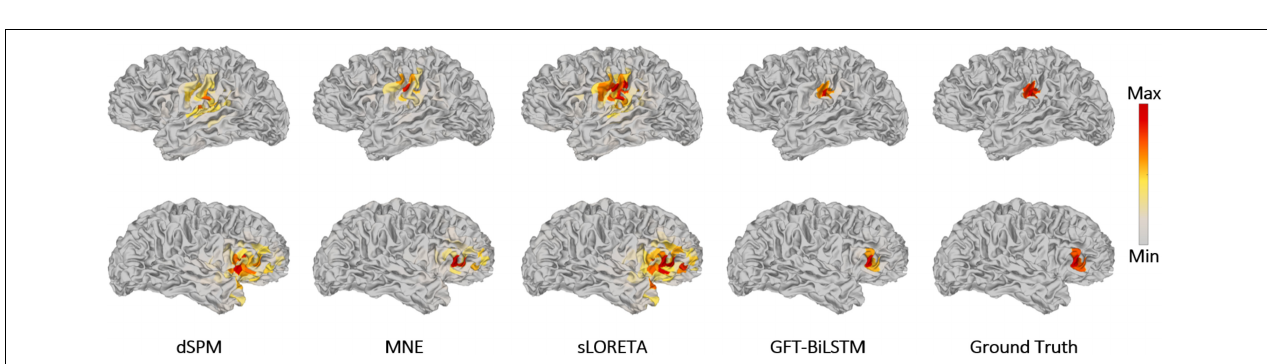
Frontiers in Neuroscience |